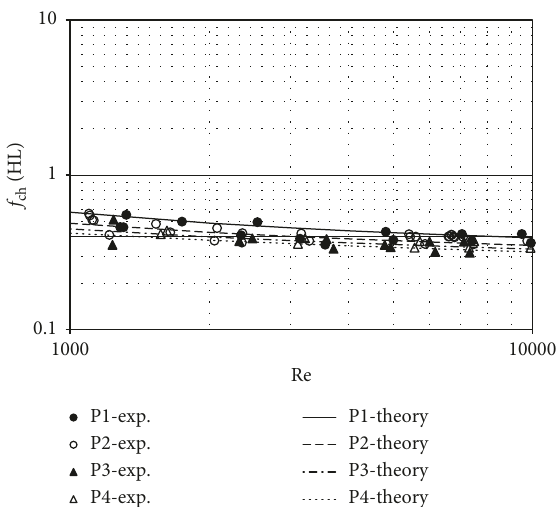
ch ( HL ) for plates P1–P4 with